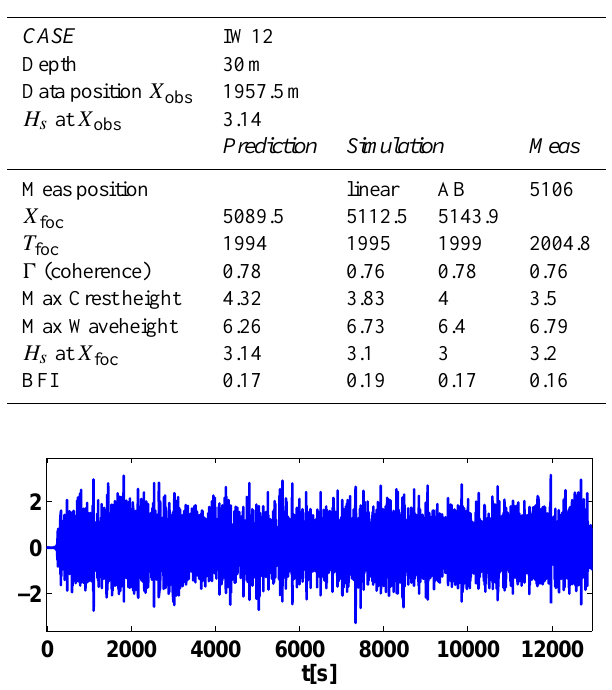
Table 3. Parameters for irregular wave IW12.